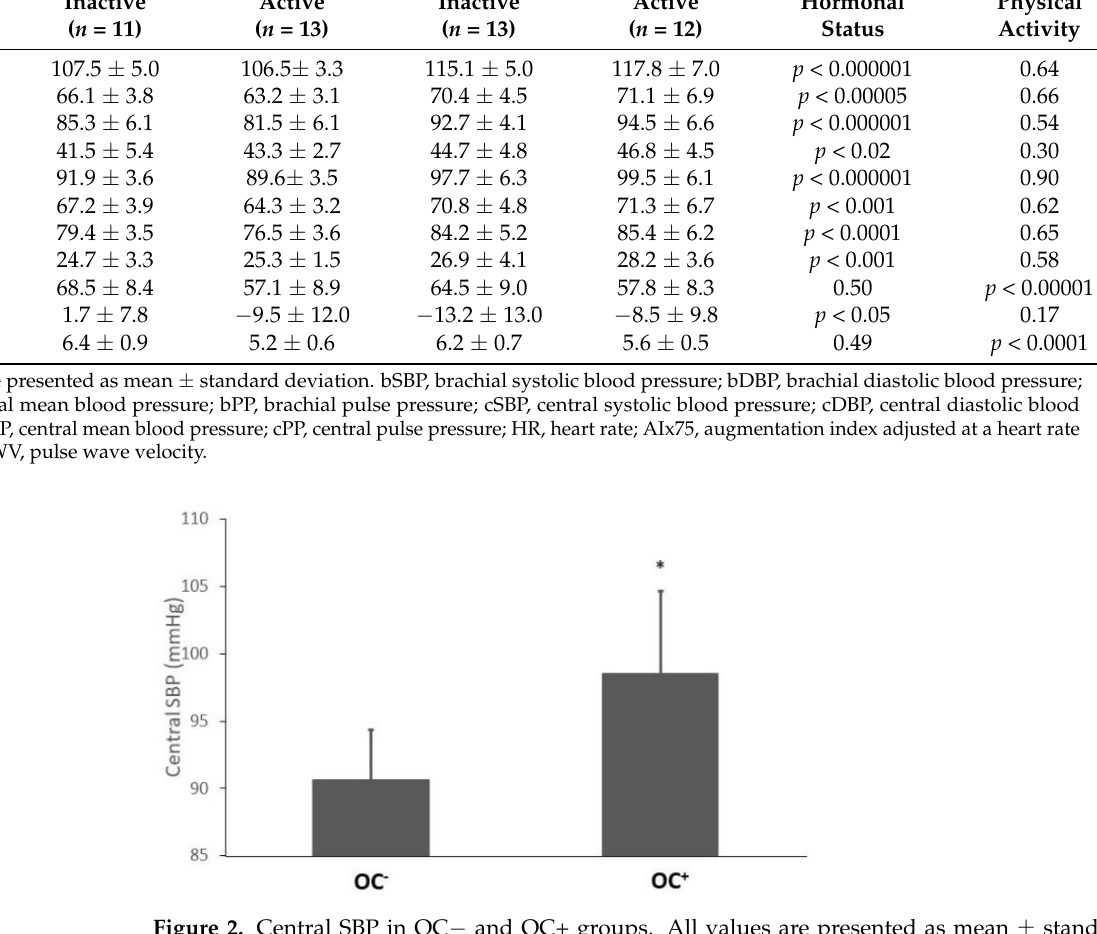
Figure 2. Central SBP in OC − and OC+ groups. All values are presented as mean ± standard deviation. Central SBP, central systolic blood pressure; * indicates significant difference between OC − and OC+ groups (OC main effect p < 0.000001).